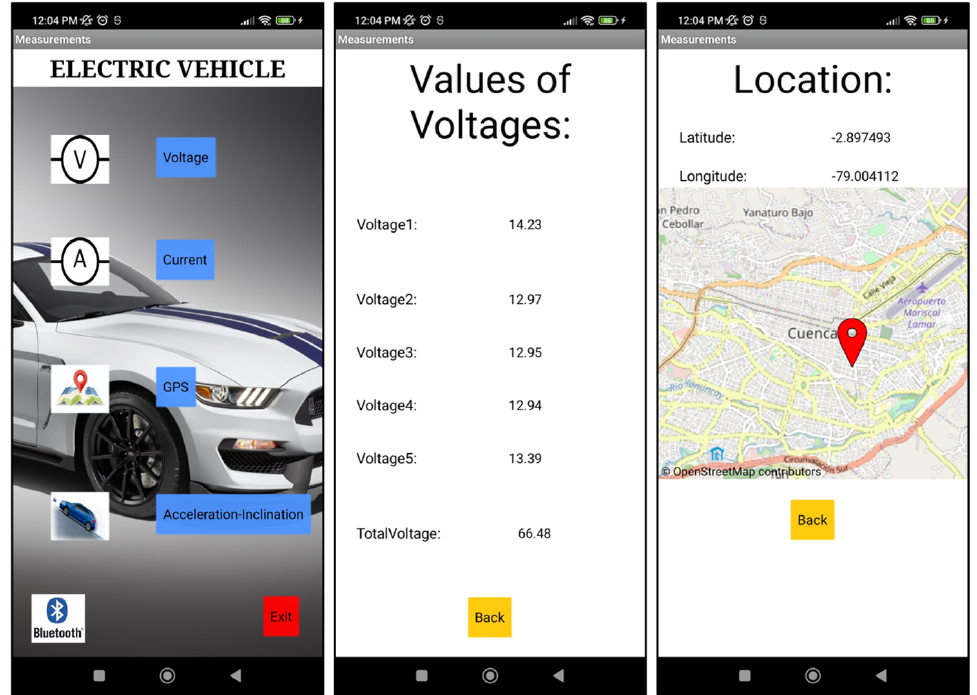
Figure 5. Screenshots of the application created in App Inventor, showing the navigation screens.